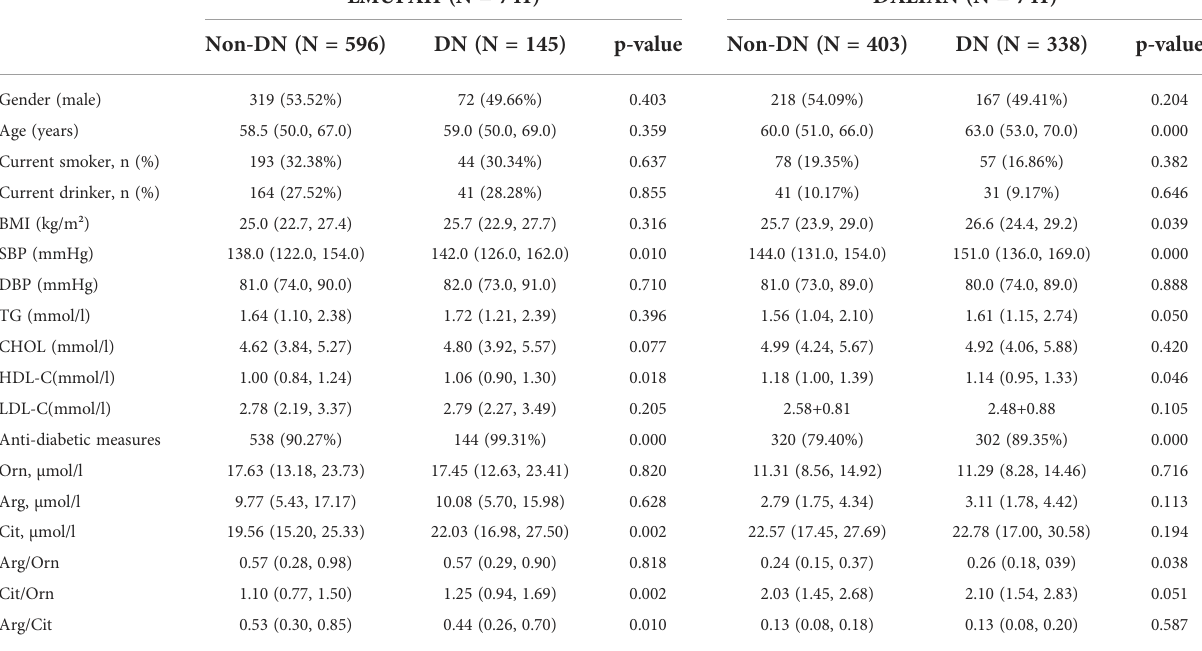
TABLE 1 Clinical and biological characteristics of all patients.